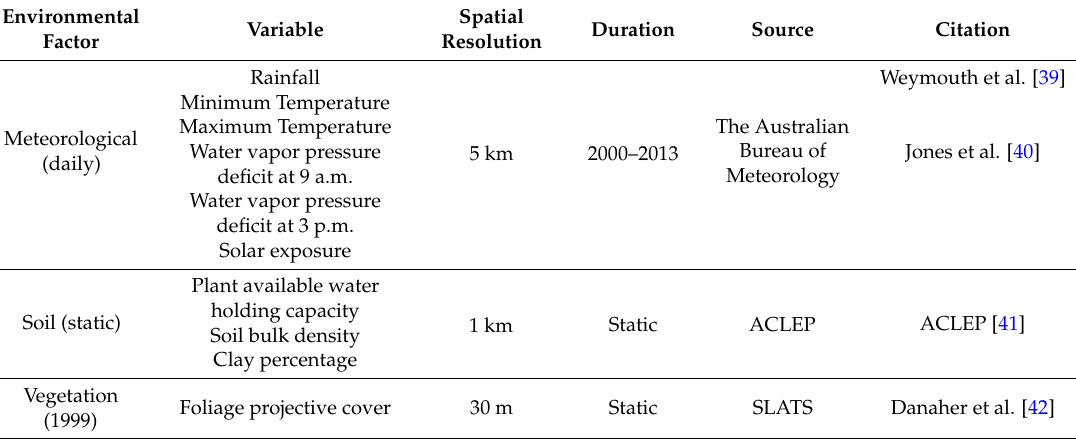
Table 1. Environmental factors used in creating land capability classes (LCCs) in the